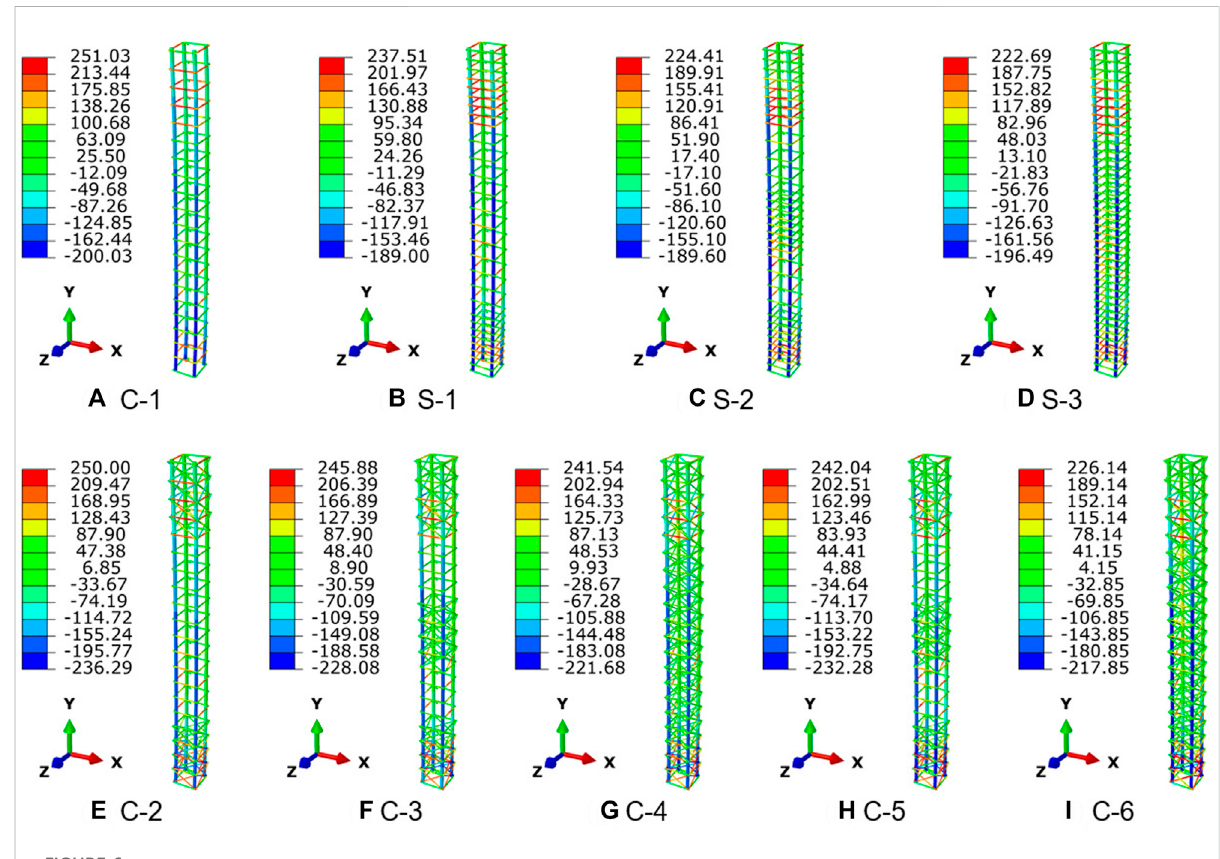
FIGURE 6 Principal stress (MPa) contour of the columns ’